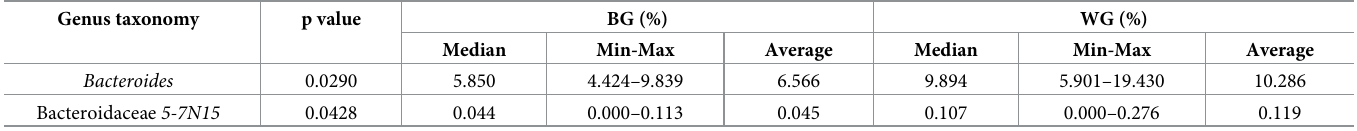
Table 2. The different genera between BG and WG.